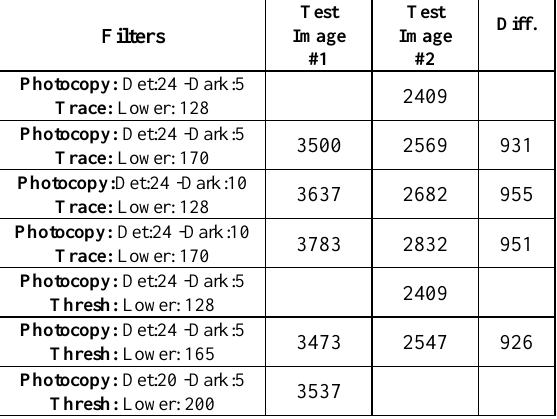
Table 5.Magic Wand tool applied on filtered